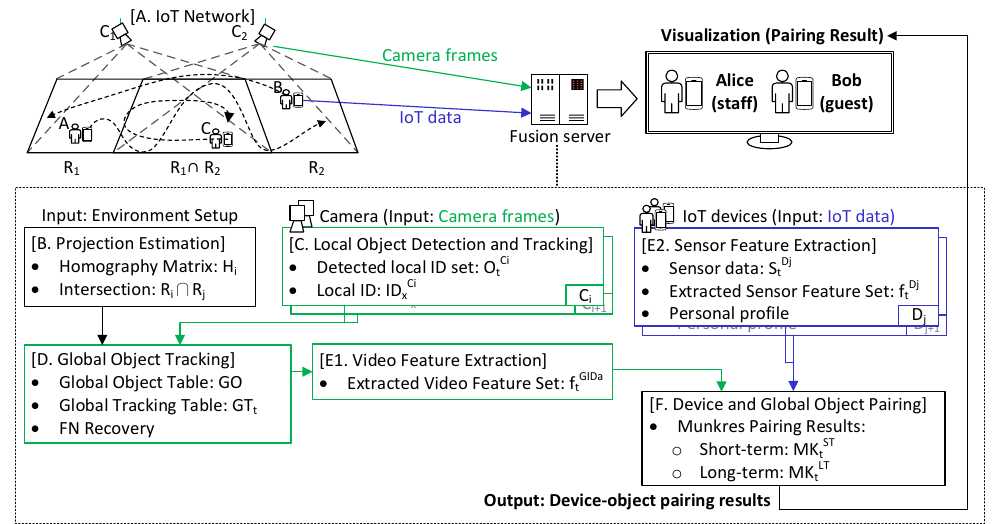
Figure 2. Data fusion